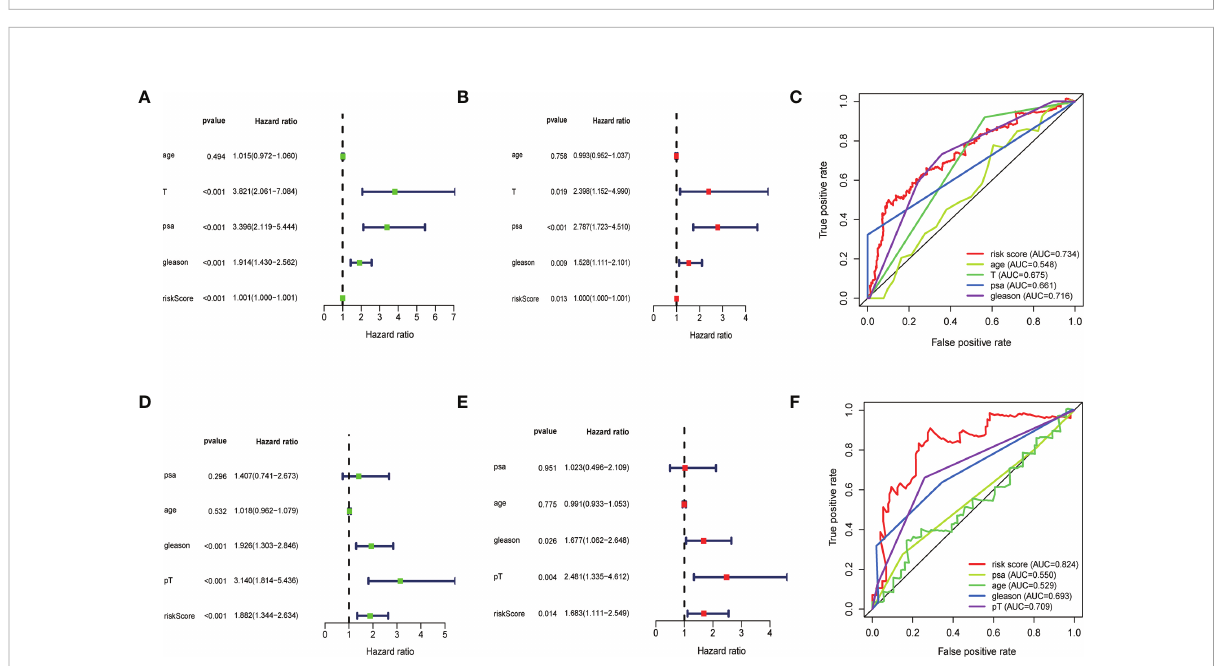
FIGURE 5 (A, B) Univariate and multivariate Cox regression analysis of the TCGA cohort. (D, E) Univariate and multivariate cox regression analyses for the MSKCC cohort. (C, F) time-dependent ROC analyses.The results showed that the risk score had signi fi cant prognostic